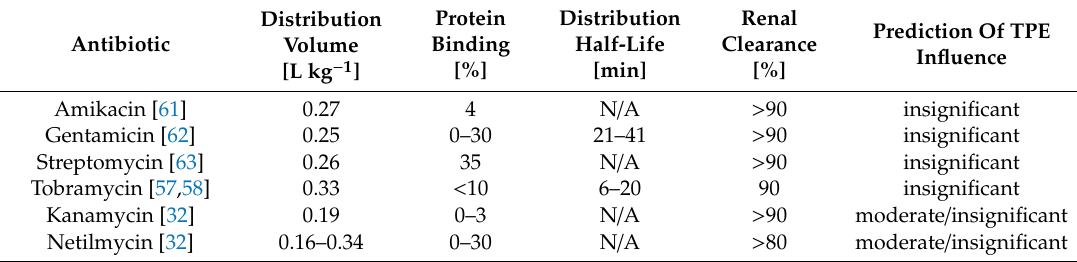
Table 3. TPE and